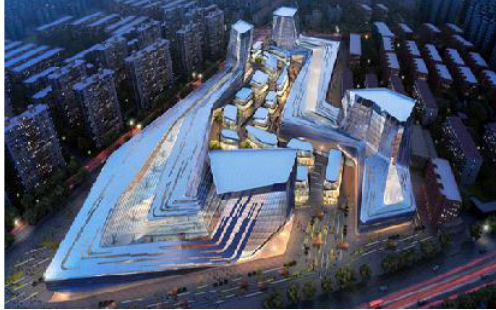
Fig. 13: Conceptual form. (Designboom, 2016)